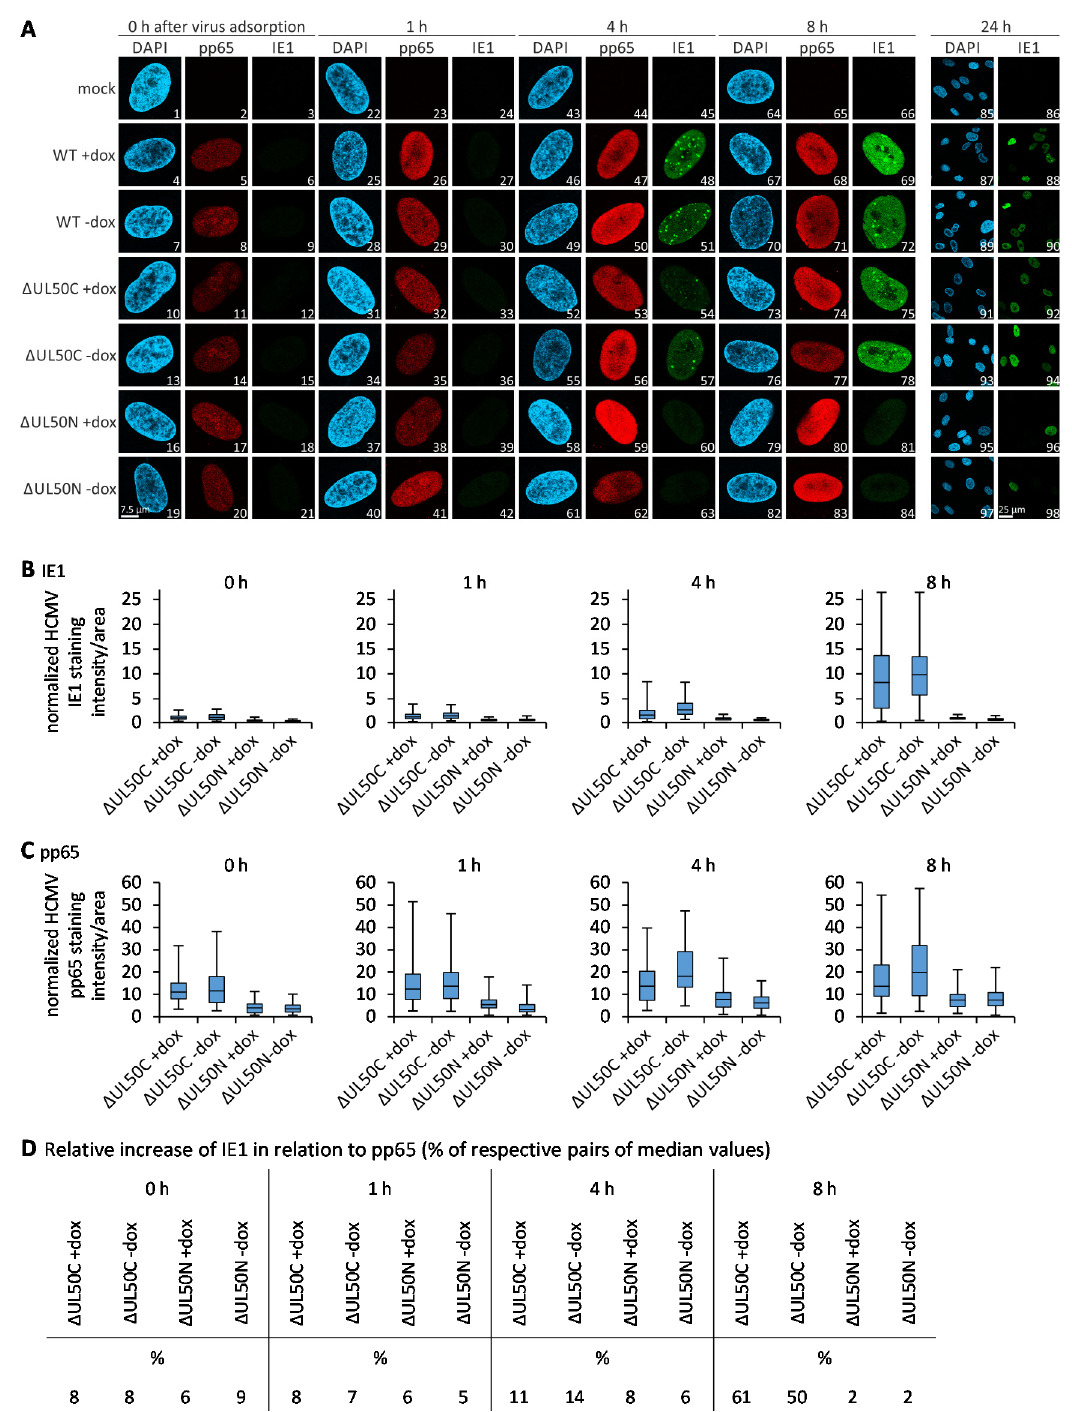
Figure 6. Activation of IE1 expression in ∆ UL50C- and ∆ UL50N-infected HFF-UL50. ( A ) HFF-UL50, either induced or uninduced, were infected with WT, ∆ UL50C, or ∆ UL50N, adjusted to identical viral genomic loads. After 1.5 h of virus adsorption, cells were fixed at the indicated time points and used for immunostaining with virus-specific antibodies and subsequent analysis by confocal imaging. The nuclei were counterstained by DAPI, and a scale bar is given in 19. Quantitation of the signal intensities of IE1 ( B ) and pp65 ( C ) as normalized to the total protein concentrations of virus inocula used for infection. The evaluation of 78 cells for each setting is depicted in box plots. Centre lines represent the medians, box limits indicate the 25th and 75th percentiles, and whiskers range from the minimum to the maximum of all data. ( D ) Median values of IE1 signal intensities in relation to the respective pp65 signals in %.